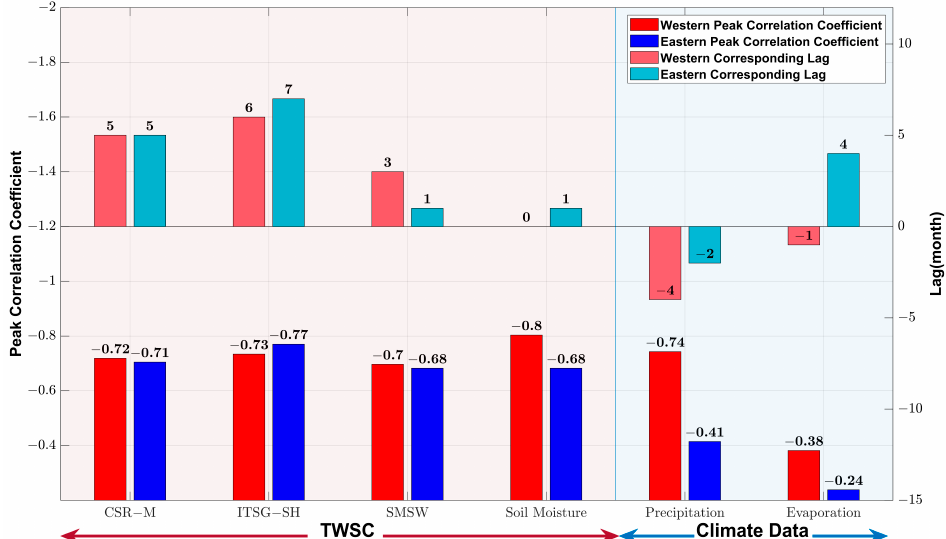
Figure 9. The peak correlation coefficients with corresponding lags between interannual signals (CSR-M, ITSG-SH, SMSW, soil moisture, precipitation, and evaporation) and ENSO in Nicaragua sub-basins. A positive/negative value of lags means that the ENSO phase is ahead/behind the interannual signal. All the peak correlations are computed at a 95% level of